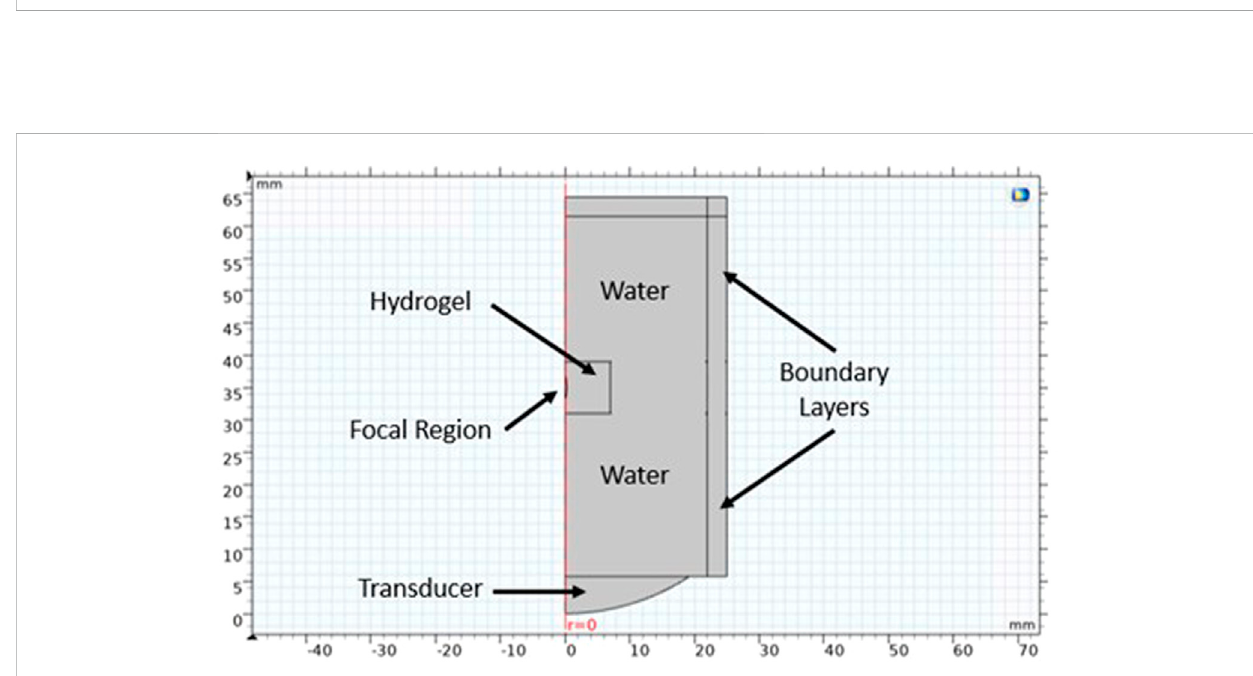
FIGURE 3 2D axisymmetric geometry used to model FUS treatment of the hydrogel in a water bath.